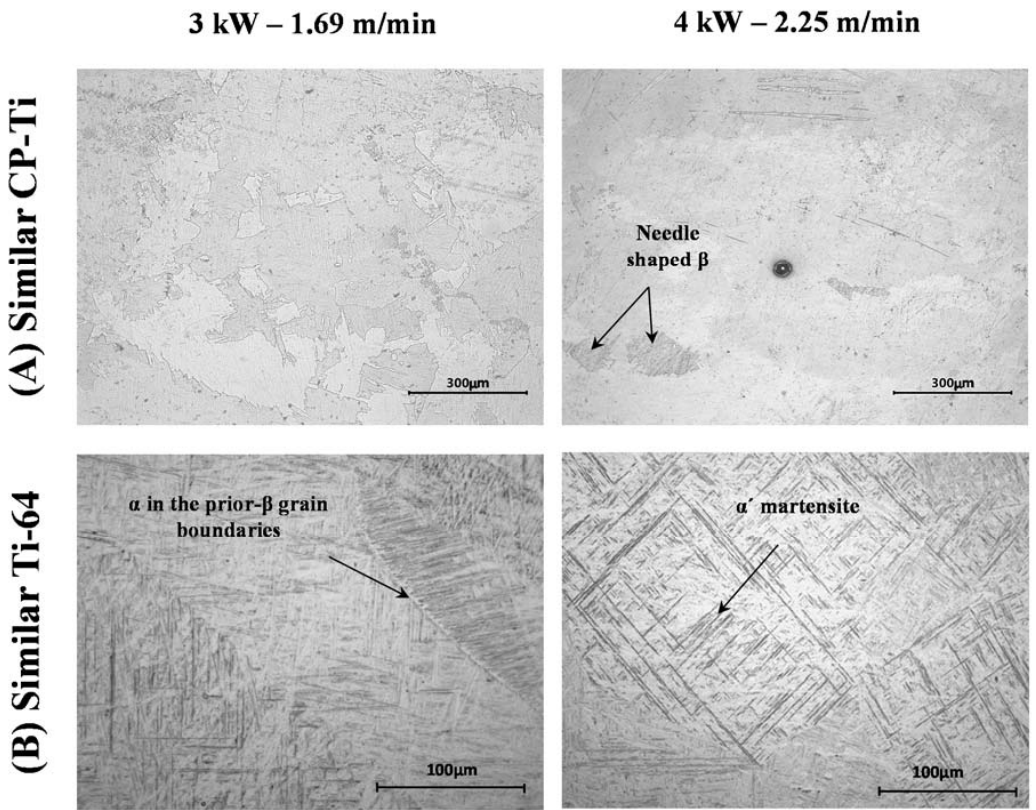
Figure 4. FZ for similar ( A ) CP ‐ Ti and ( B ) Ti ‐ 64 joints welded by 3 and 4 kW laser power. It should be noted that images with lower magnification are shown for CP ‐ Ti to accommodate large alpha grains.